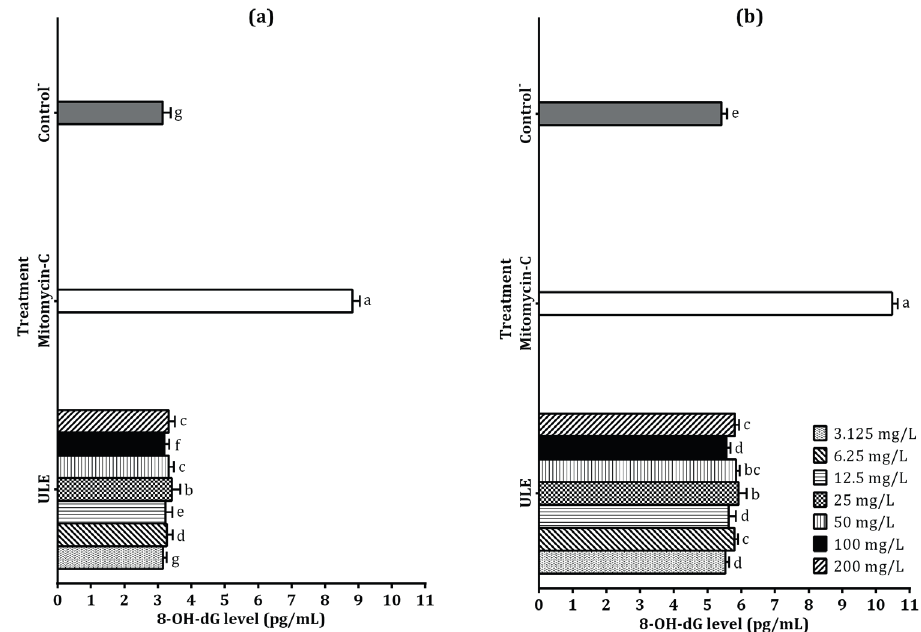
Figure 6 - 8-OH-dG adducts in the cells in the presence of ULE (a) for PMGN cells (b) for U87MG cells. each value is expressed as mean ± standard deviation ( n = 3). Values followed by different small letters differ significantly at p <